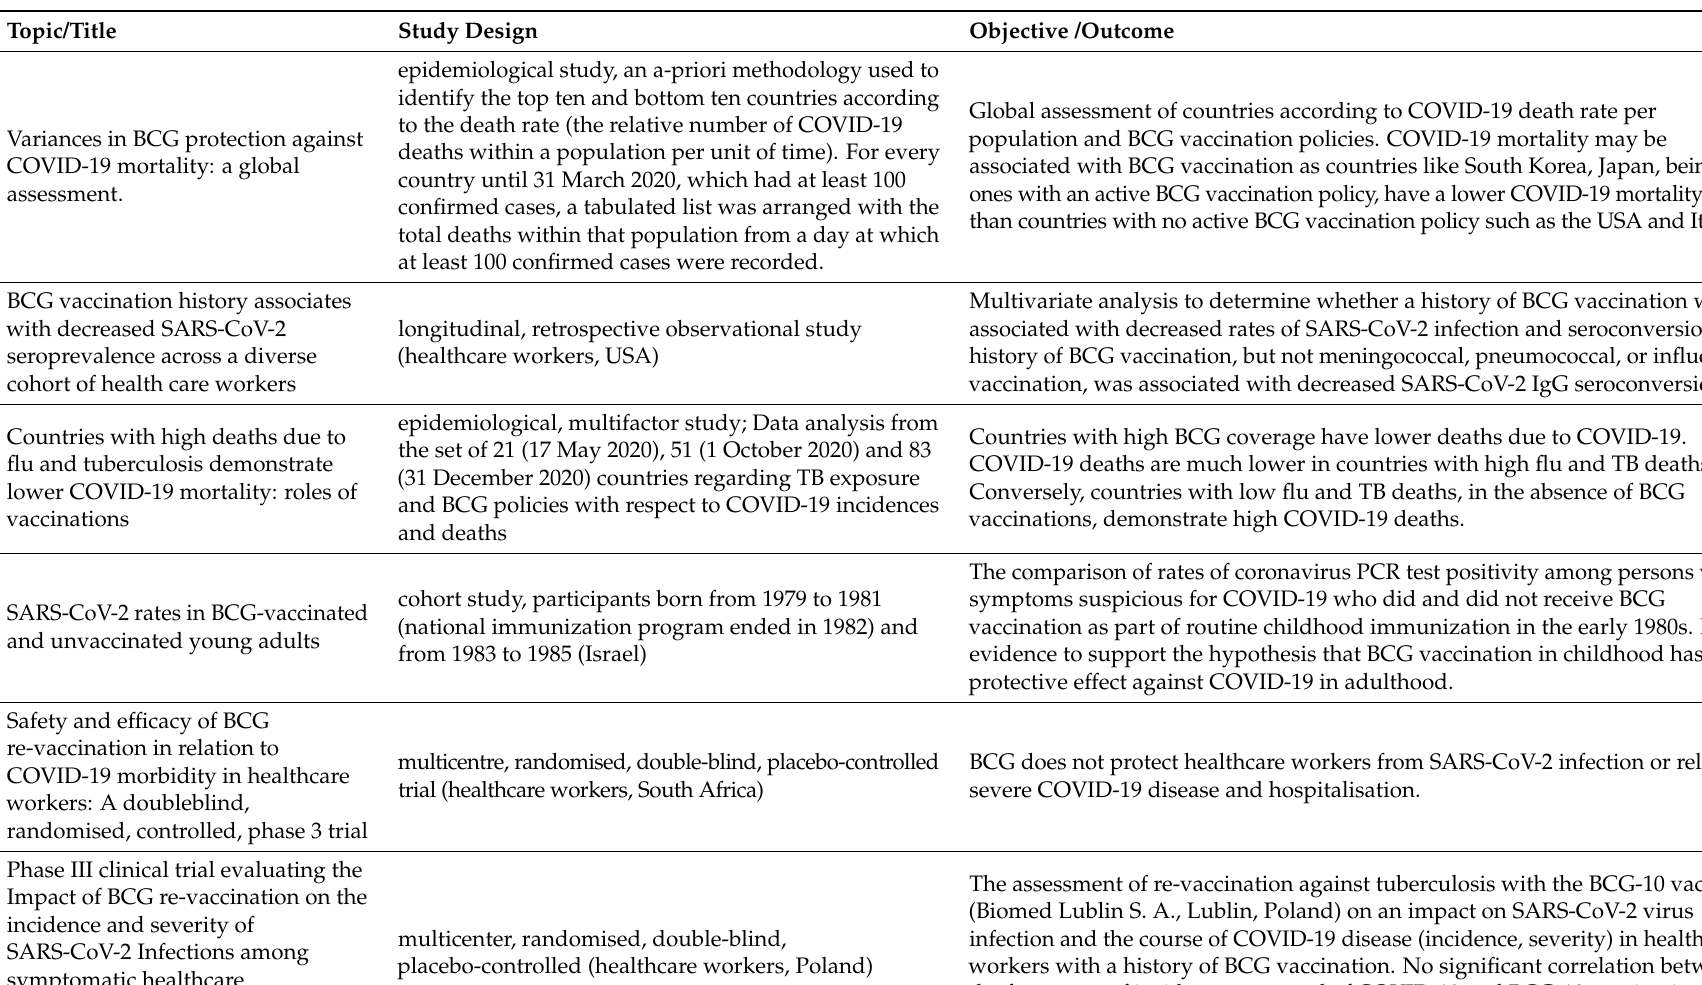
Table 1. Exemplary studies on the possible connection between BCG vaccination and